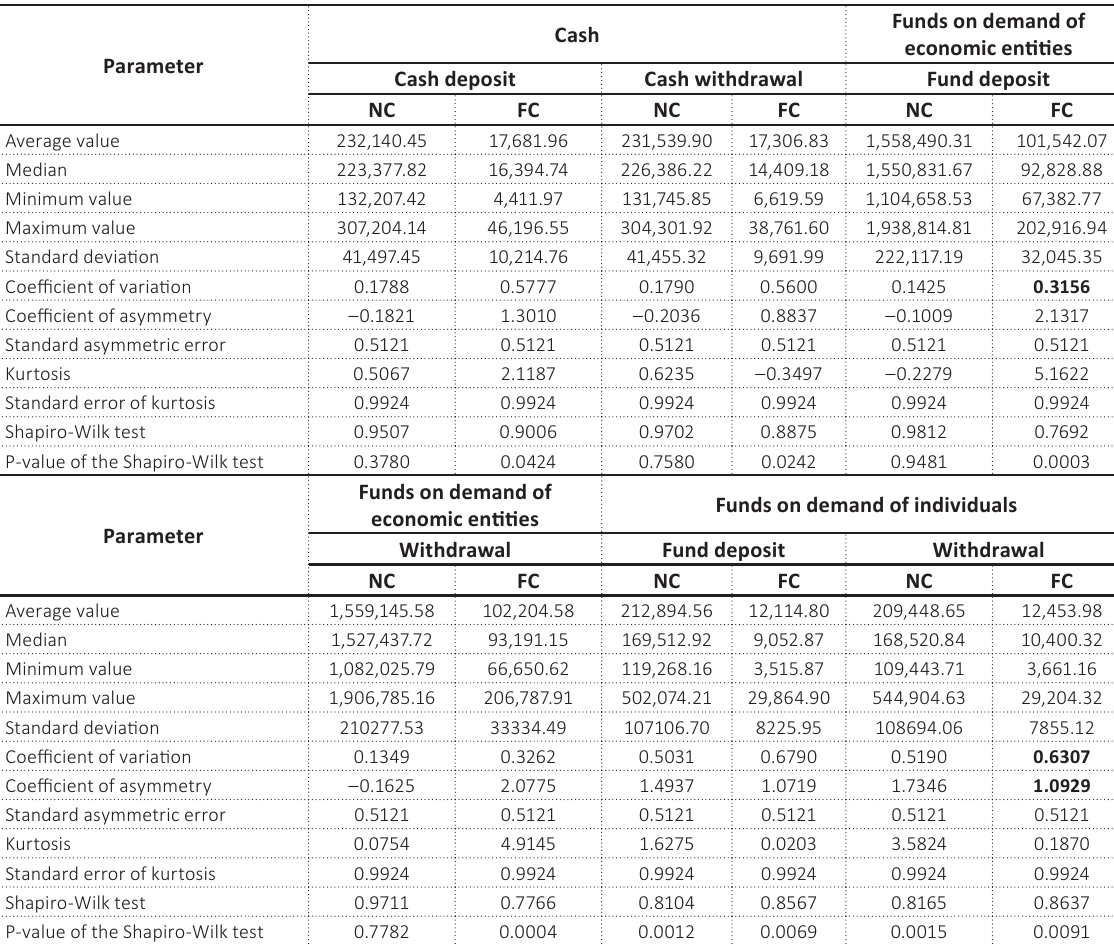
Table 5. Statistical characteristics of the dynamics of cash turnover and funds on the on-demand accounts from September 1, 2017 to April 1, 2019 for JSC “ASVIO